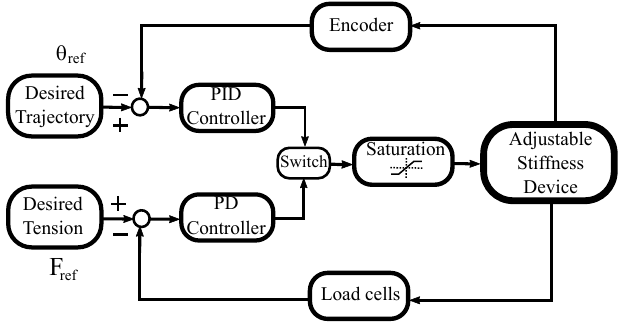
Figure 6. Control